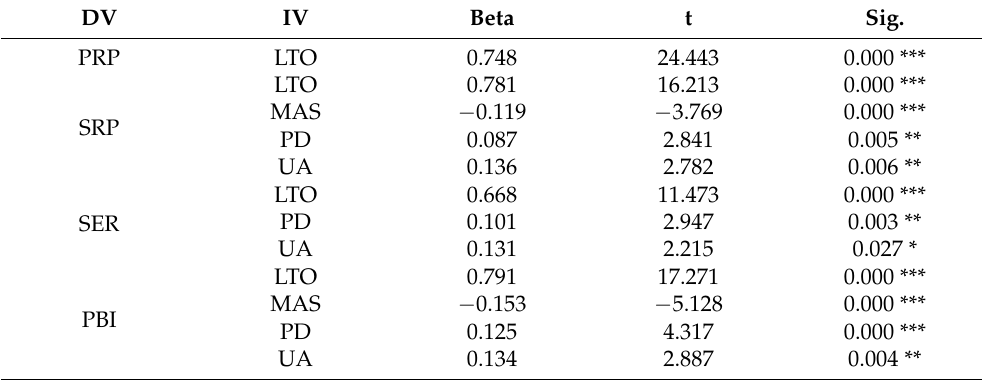
Table 7. The impact of cultural differences on health perception between the US and